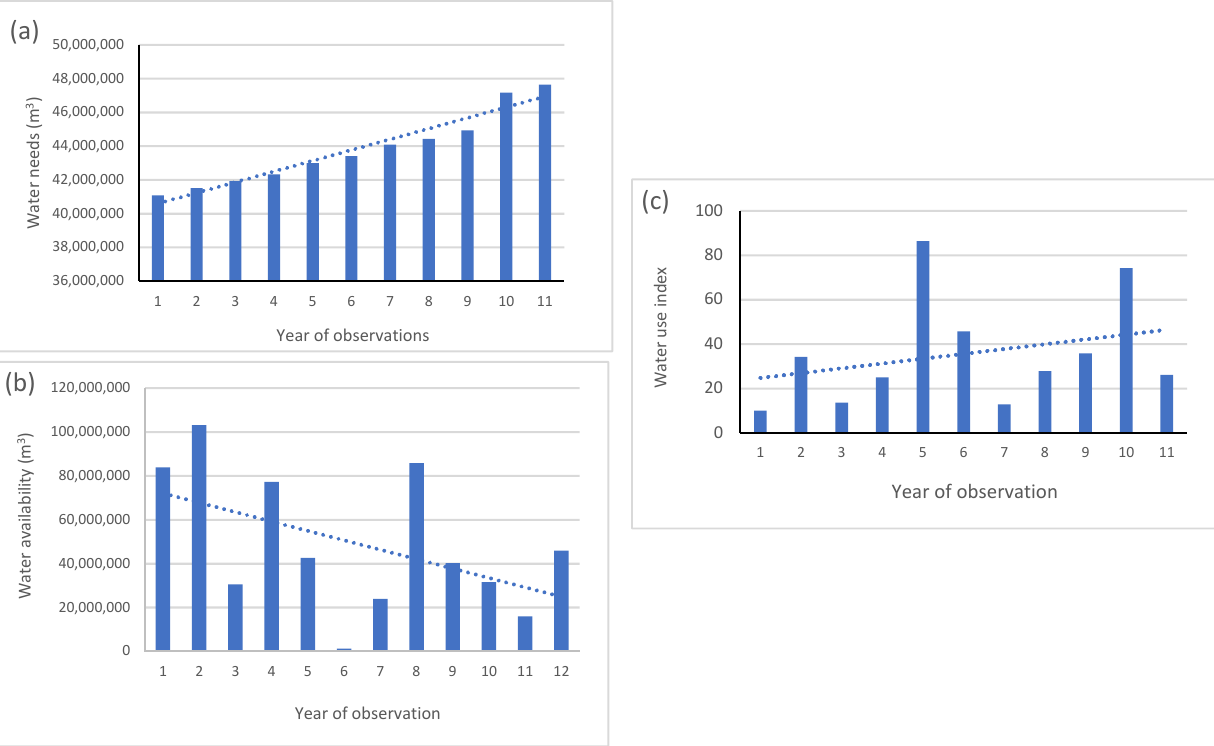
Figure 3. The trend of water needs in the Dodokan Watershed from 2010–2020 ( a ); water availability in the Dodokan Watershed from 2009–2020 ( b ); and the water use index in the Dodokan Watershed from 2010–2020 ( c ).